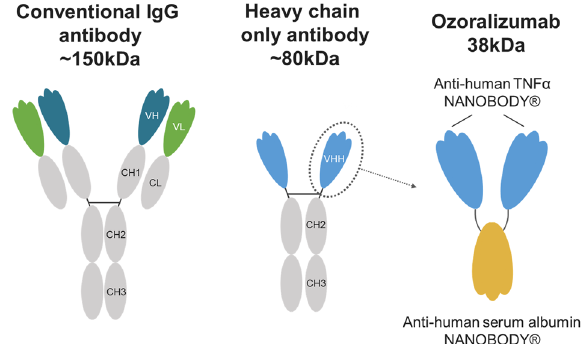
Figure 1. Schematic representation of a conventional IgG antibody, heavy-chain-only antibody, and